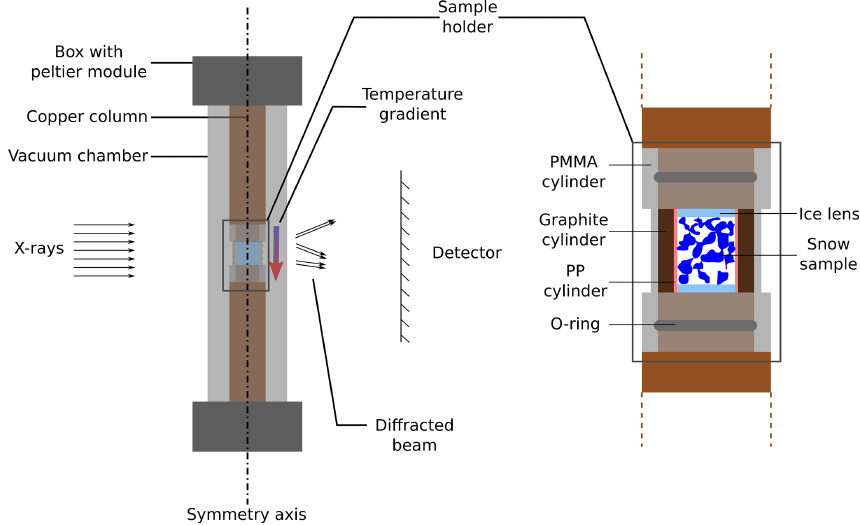
Figure 1. Scheme of the cryogenic cell CellDyM2, the DCT-compliant version of CellDyM (Calonne et al., 2015).